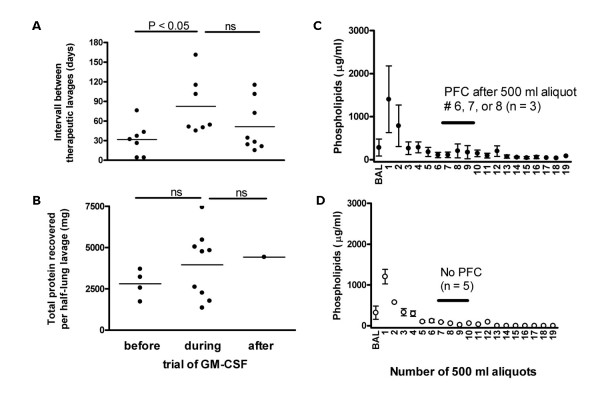
At age 5 y, during four consecutive whole lung lavage sessions perfluorocarbon (PFC) was instilled into the lungs after the 6th, 7th, or 8th of the 500 ml wash in order to enhance the recovery of surfactant material. The concentration of phosphoplipids (and total protein (not shown)) washed out was not significantly altered compared to lavages done at that age without PFC (Figure. 4 A, B). From age 3 to 4 1/2 years therapy with inhaled and subcutaneous injections of recombinant GM-CSF was done (see also Figure. 2 B). Although the intervals between consecutive therapeutic whole lung lavages were increased with GM-CSF treatment the amount of protein removed was also increased, demonstrating no reduction of protein amount with GM-CSF treatment (Figure. 4 C, D). Note that not all lavages were available for total protein measurements.